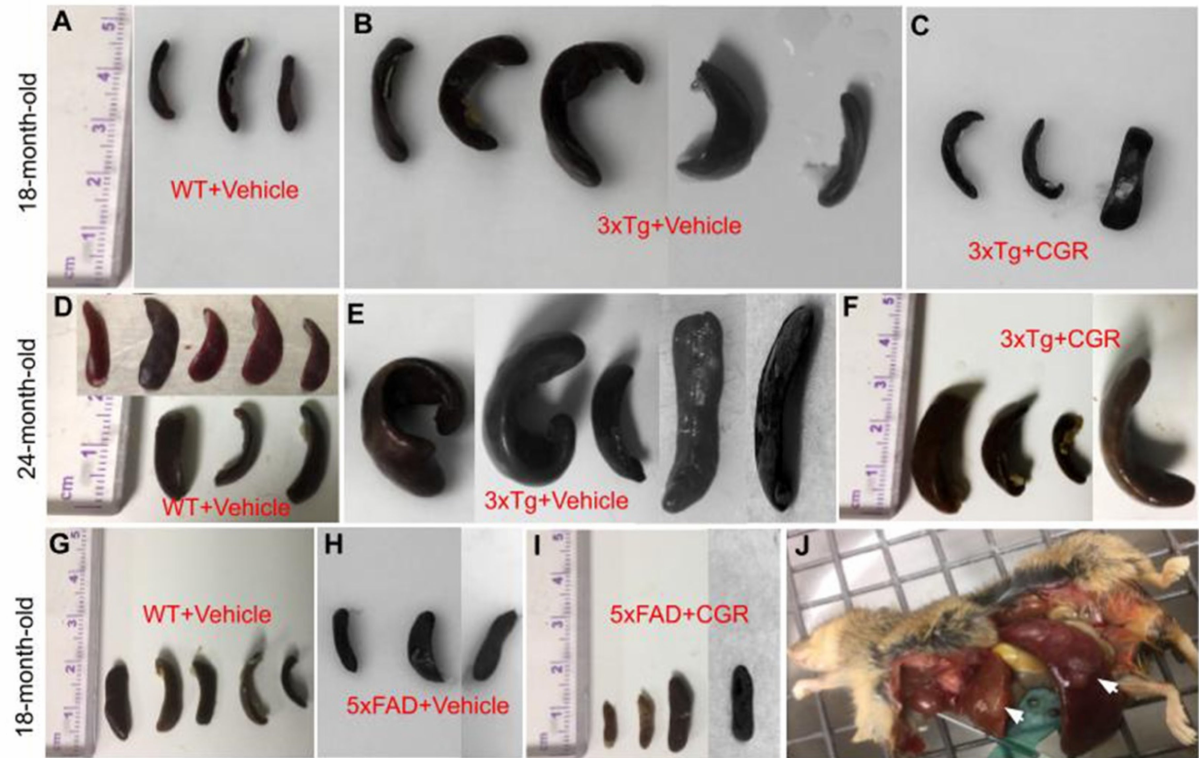
Figure 2. Splenomegaly was prevented by CGR treatment in 3xTg mice. Wild-type, 3xTg, 5xFAD mice were treated with CGR and the spleens were assessed after perfusion and fixation with 4% paraformaldehyde. ( A – F ): Spleens from WT+Vehicle ( A ), 3xTg+Vehicle ( B ) 3xTg treated with CGR, ( C ) 18-month-old WT+Vehicle ( D ), 3xTg+Vehicle ( E ), and 3xTg+CGR, and ( F ) 24-month-old 3xTg mice were measured. Note that the splenomegaly in 3xTg mice was significantly decreased in both 18- and 24-month-old groups after CGR treatment. ( G – I ) Spleens from WT+Vehicle ( G ), 5xFAD+Vehicle ( H ), and 5xFAD mice treated with CGR ( I ). Note that there was no significant change of spleen size in 5xFAD or 5xFAD+CGR mice in comparison to WT mice. ( J ) Representative image of a 24-month-old 3xTg mouse with splenomegaly and hepatomegaly